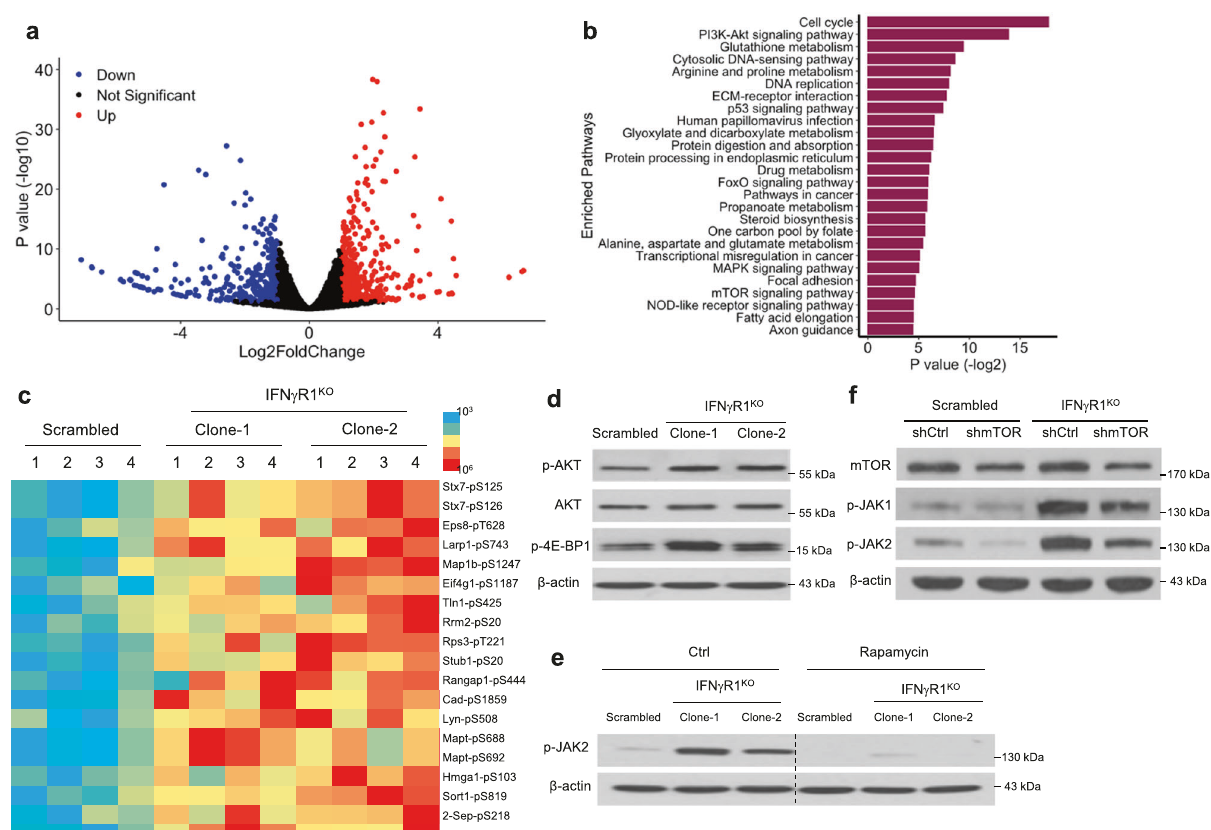
Fig. 5 | Heightened PI3K-AKT-mTOR axis in IFN γ R1 KO cells mediates JAK1/2 activation. a , b Upregulated and downregulated genes in scrambled ( n =3) and IFN γ R1 KO ( n =3) cells by RNA-Seq ( a ) and top hits of altered signaling pathways in IFN γ R1 KO cells ( b ). The gene expression analyses were performed using DESeq2 (version 1.34.0). The Wald test was used to calculate the p values and log2 fold changes. Genes with an adjusted p value <0.05 and absolute log2 fold change >1 were considered asdifferentially expressed genes (DEGs).A volcano plot wasused to show all upregulated and downregulated DEGs using the ggplot2 R package. EnrichedKyotoEncyclopediaofGenesandGenomes(KEGG)pathwaysoftheDEGs were identi fi ed by enrichr package. Signi fi cant terms of the KEGG pathways were selected with a p value <0.05. c Cell lysates of scrambled control ( n =4)